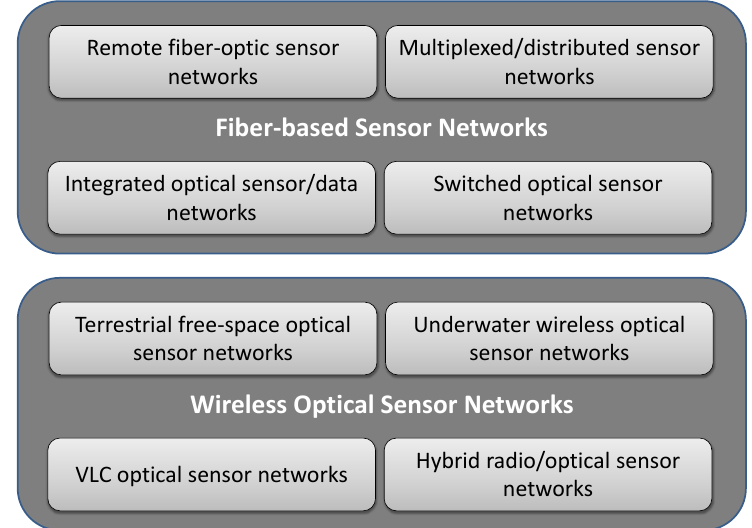
Figure 4. Di ff erent types of fiber-based and wireless optical sensor networks (VLC: Visual Light Communication).